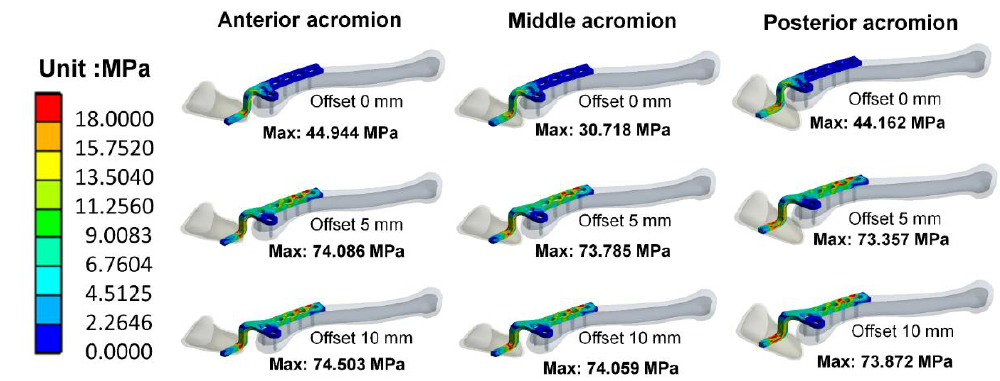
Figure 6. The distribution of von Mises stress on the clavicle hook plate.